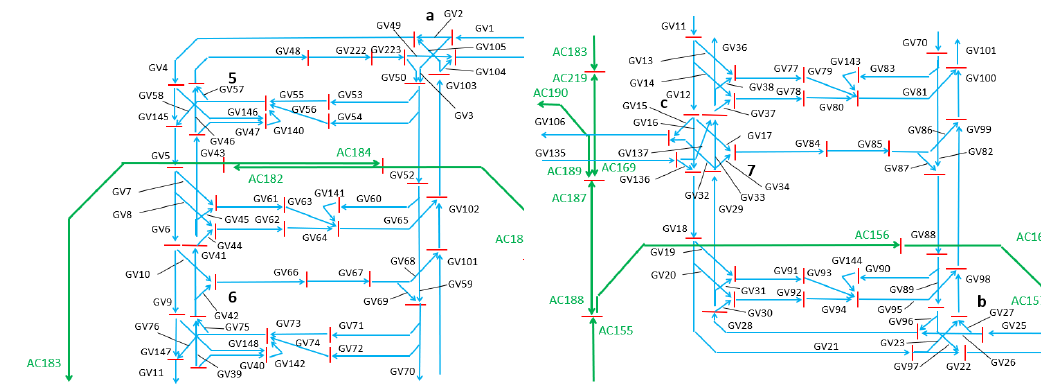
Figure 2. Topology and designation of sections of the transport network